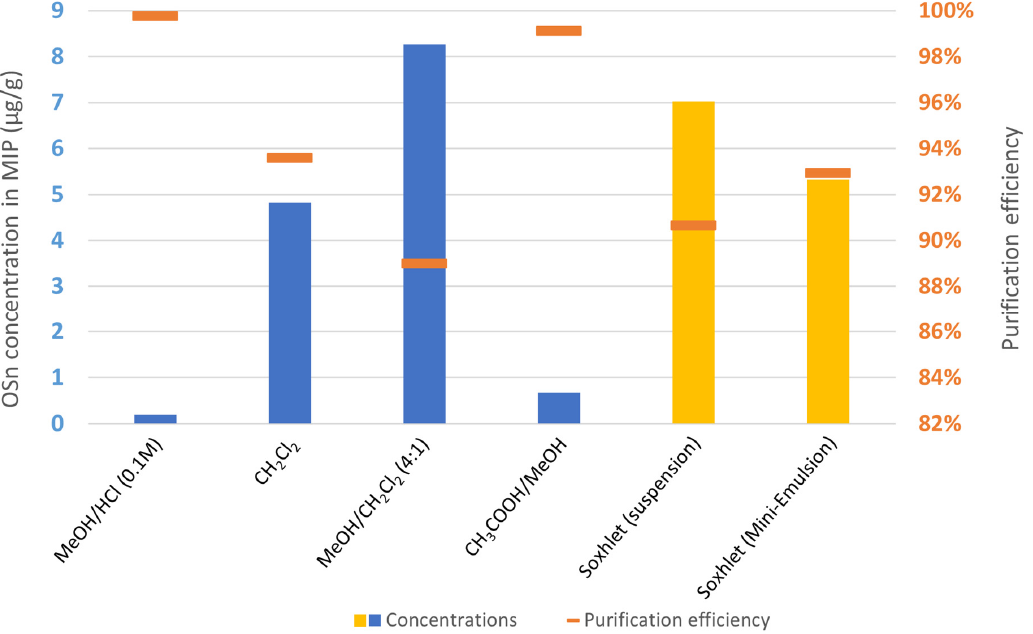
Figure 7. OSn concentrations remaining in the extracts of suspension synthesized MIP after washing steps and its respective removal efficiencies. OSn concentrations and efficiencies after Soxhlet steps and before washing steps.